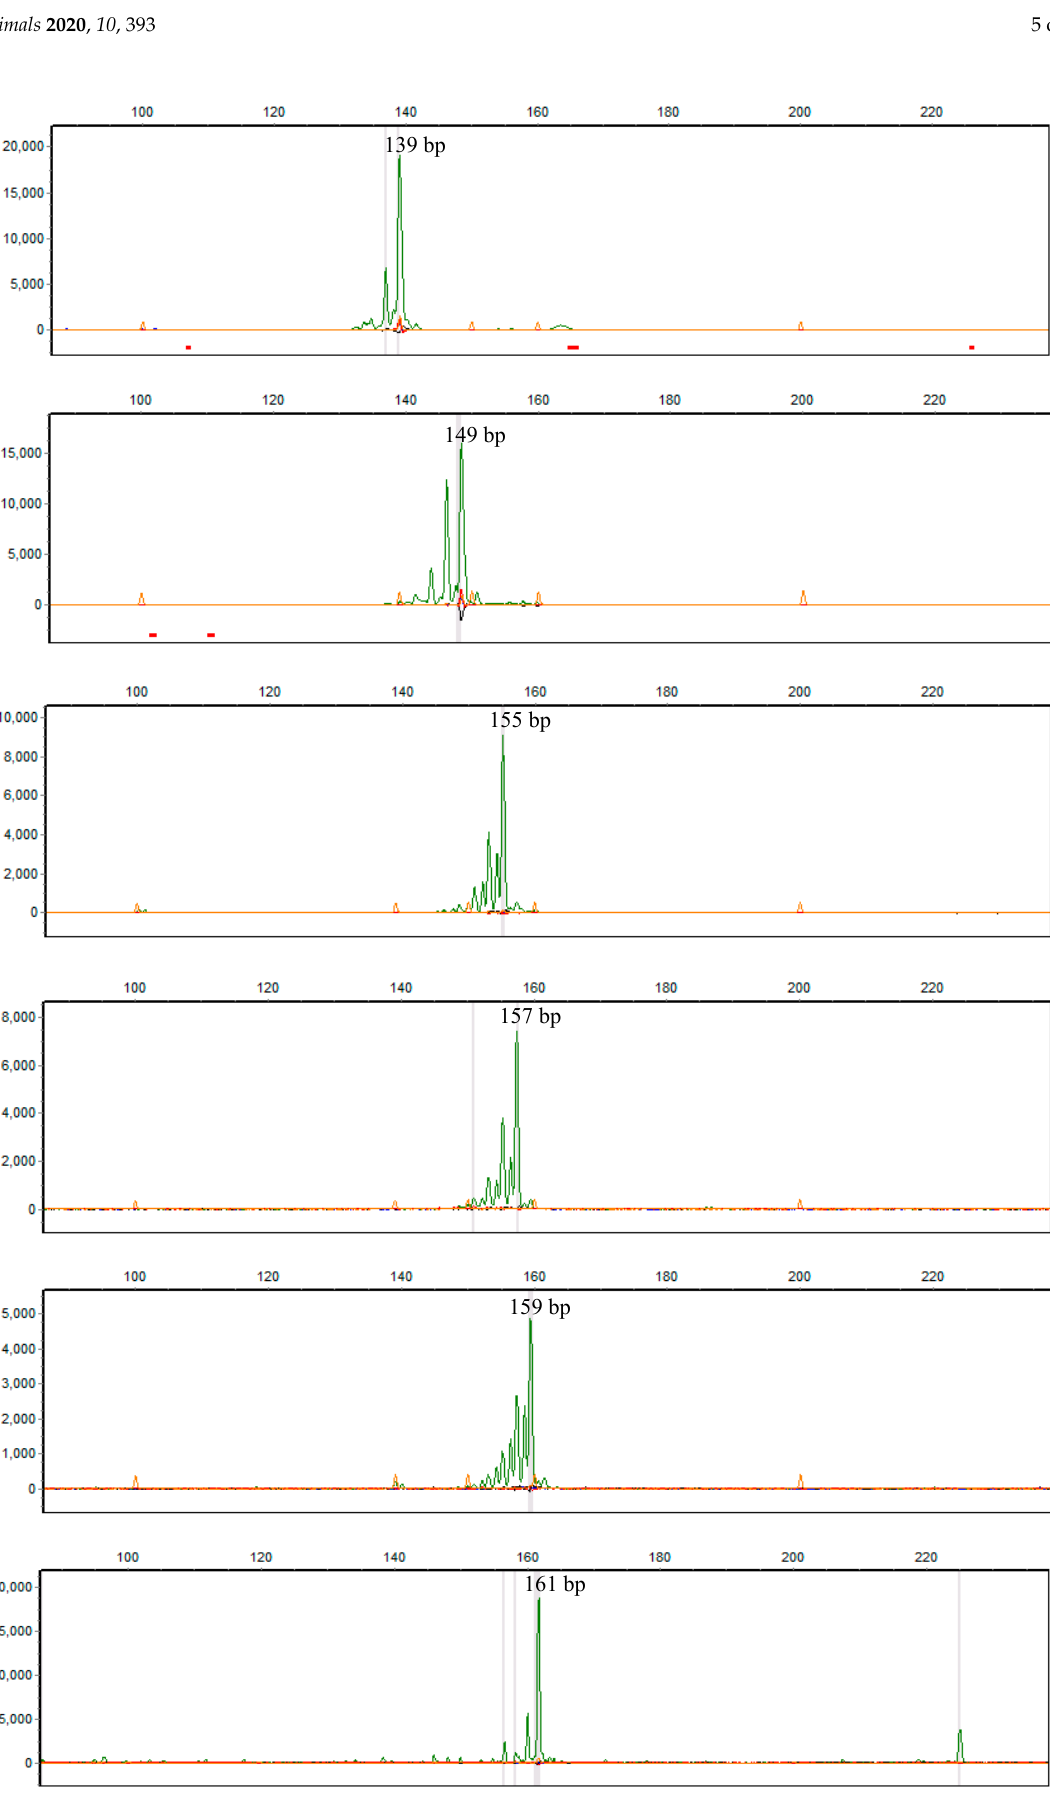
Figure 2. Genotyping of yak Y-STR INRA189 marker.